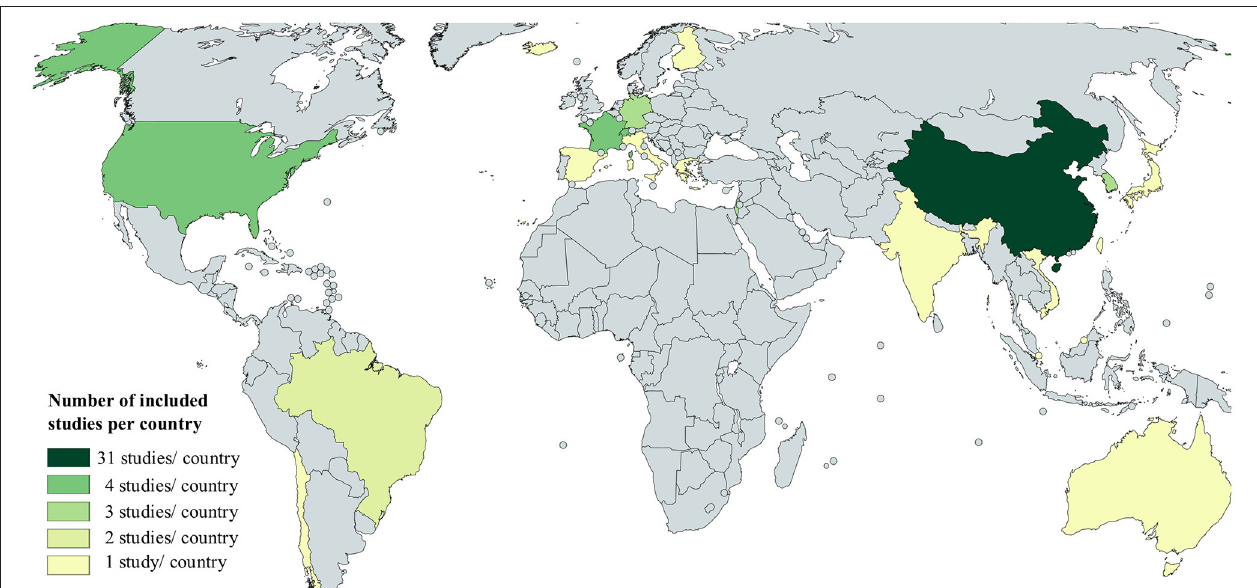
FIGURE 2 | Overview of the origin of studies included in this